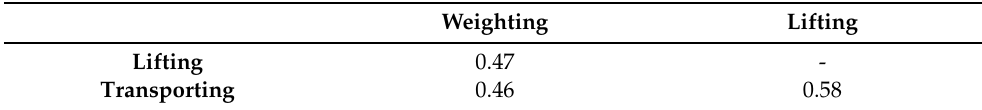
Figure 4. Results averaged among participants for the “transport” condition. ( a ) Mean dendrogram showing the resulting sensorimotor representation structure. The red horizontal line denotes the Euclidean critical distance. The critical value of the Euclidean distance was 4.59 at a 1% level of signif- icance (i.e., d Crit = 4.59, α = 0.01). Clusters that occur beneath the horizontal red line are statistically significant. ( b ) Spheres used in the experiment with their corresponding feature dimension levels. ( a , b ) Each color represents a significant cluster and its corresponding subset of spheres. Table 3. Invariance analysis results for the three conditions. The difference is significant for any value under λ =